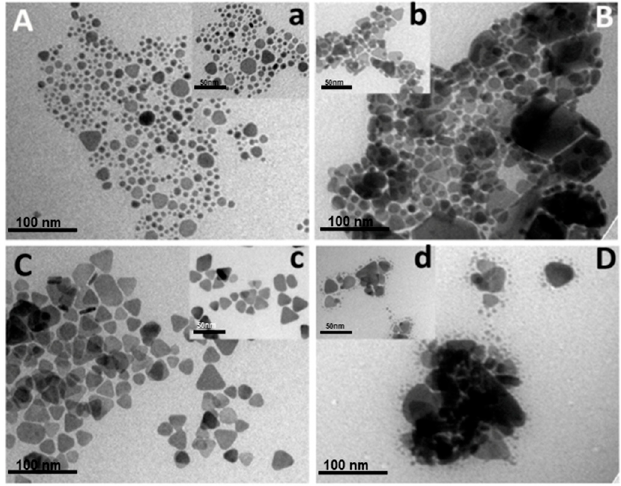
Figure 5. TEM images ( A–D , scale bar 100 nm) and inset ( a – d , scale bar 50 nm) show the HR-TEM images of Ag-NPrs obtained in the four concentrations of tri-sodium citrate di-hydrate (TSCD) and di-sodium succinate hexa-hydrate (DSSH) ratio. Table 1. Reaction conditions for the Ag-NPrs synthesis in a total volume of 10 mL aqueous solution. No. H 2 O